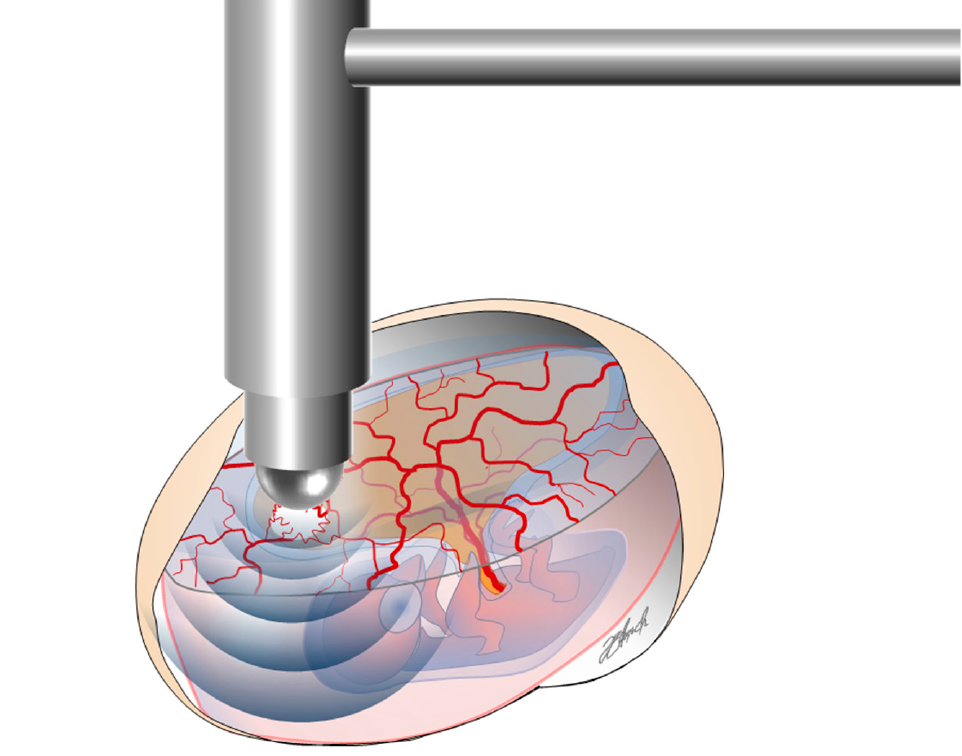
Figure 13. Experimental set-up for shock-wave application. The cavity was filled with 0.9% NaCl solution and the tip of the applicator was immersed into the solution. At an energy flux density of 0.12 mJ / mm 2 , 500 impulses were applied with the applicator centered above the CM.